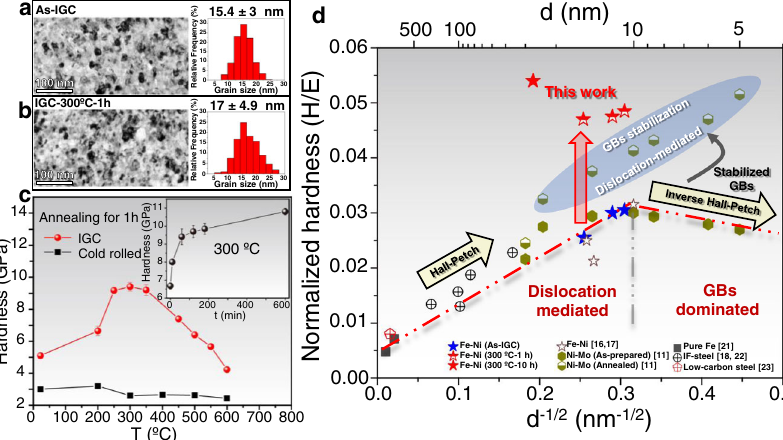
Fig. 1 | Nanograined Fe-Ni alloy fabricated by IGC and the effect of annealing. a , b Bright- fi eld micrograph and grain size distribution of the IGC samples before and after annealing at 300°C for 1h. c Microhardness as a function of annealing temperature for the IGC nanograined Fe-Ni and cold-rolled Fe-Ni alloys, and the